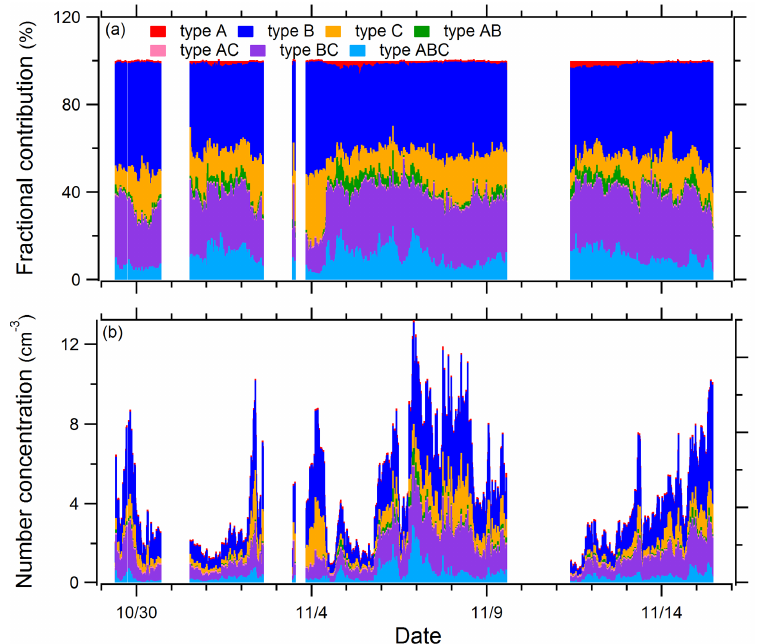
Figure 4. Time series of (a) the fractional contribution of each fluorescent type to total FAPs and (b) number concentration (left axis) of each fluorescent type. Type A: red; type B: blue; type C: dark yellow; type AB: green; type AC: pink; type BC: purple; type ABC: light